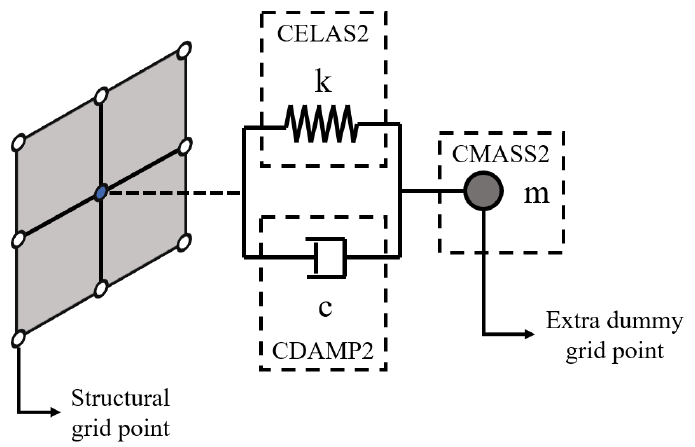
Figure 2. Schematics of a TMD modelled in MSC NASTRAN ® .